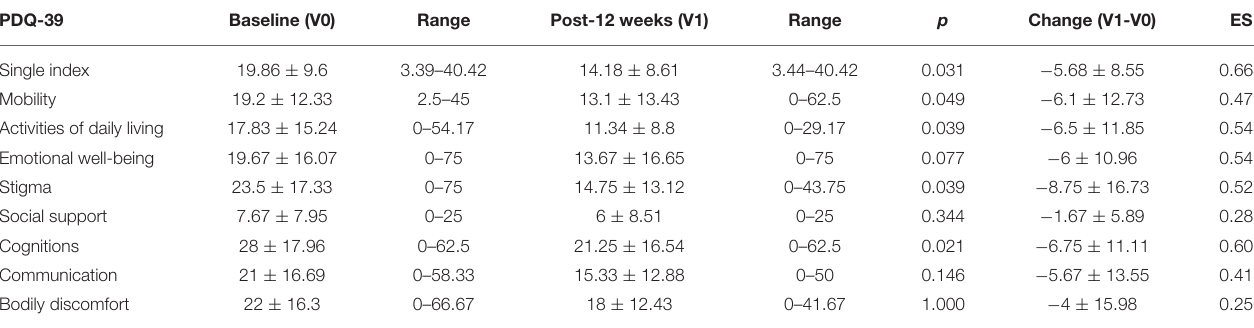
TABLE 4 | The 39-item Parkinson’s disease questionnaire of patients with PD at baseline and after 12 weeks of intervention.